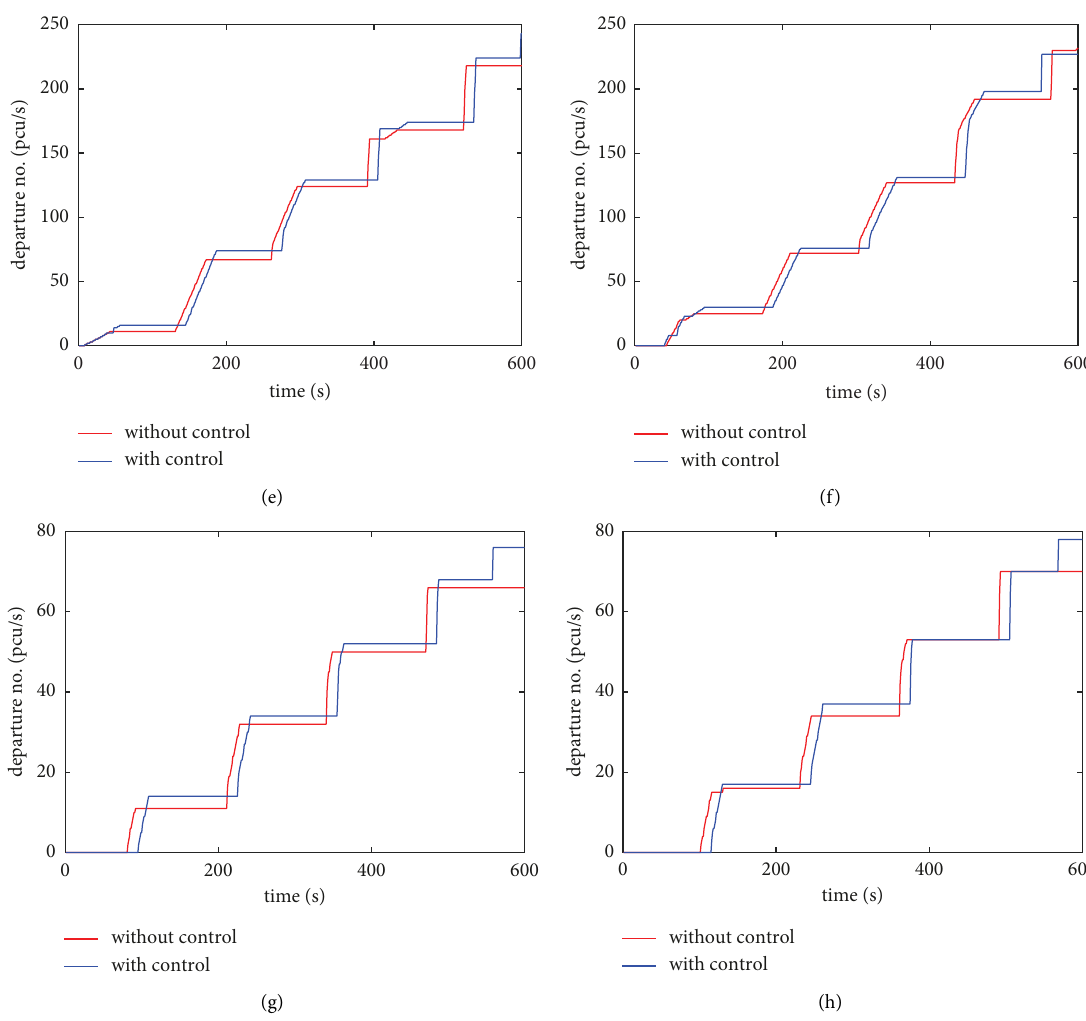
Figure 7: Comparison of vehicle departure numbers without and with control. (a) Phase one. (b) Phase two. (c) Phase three. (d) Phase four. (e) Phase fve. (f) Phase six. (g) Phase seven. (h) Phase